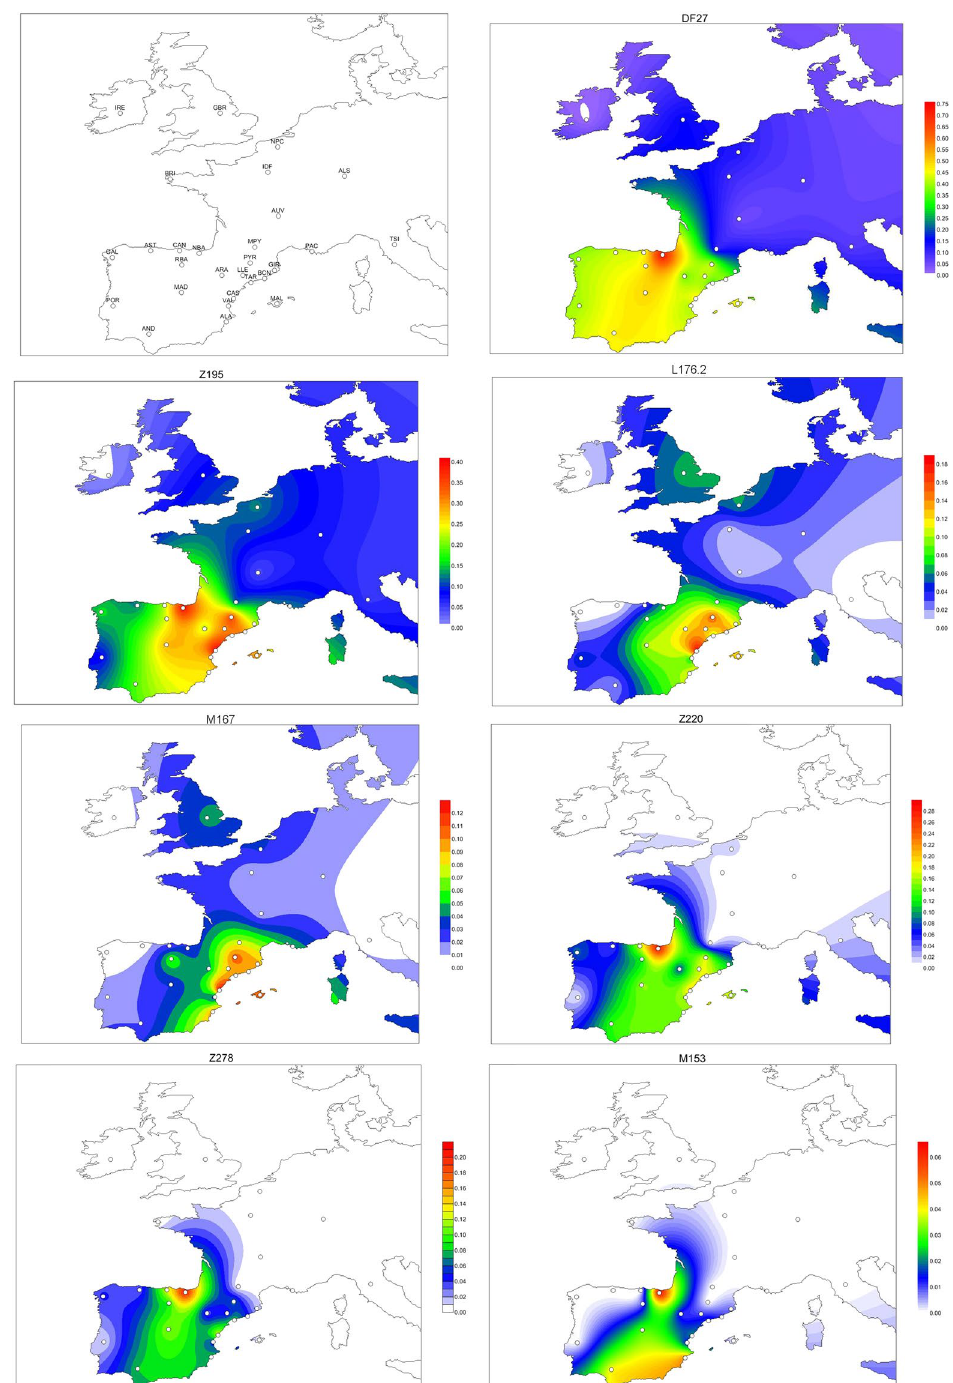
Figure 2. Contour maps of the derived allele frequencies of the SNPs analyzed in this manuscript. Population abbreviations as in Table 1. Maps were drawn with SURFER v. 12 (Golden Software, Golden CO,